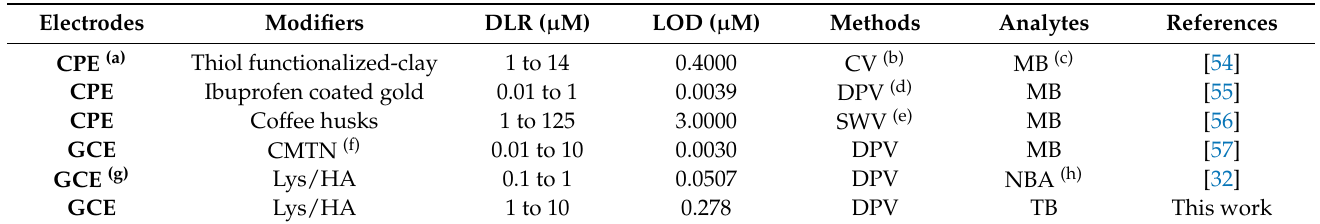
Figure 9. DPV curves obtained on GCE/Lys/HA in PBS (pH 6) at different concentrations (0, 1, 2, 3, 4, 6, 7, 8, 9 and 10 µM) of TB. (The inset shows the corresponding calibration curve.). Table 3. Comparison of the detection limit of TB on the GCE/Lys/HA sensor with those obtained for other dyes analyzed by other modified